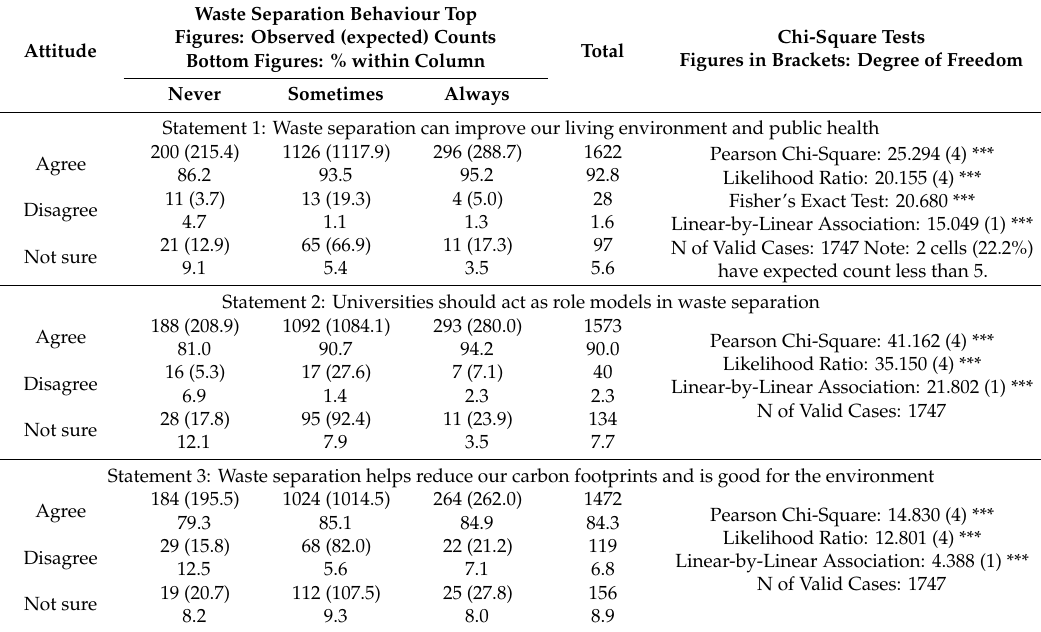
Table 7. Attitude towards waste separation and waste separation